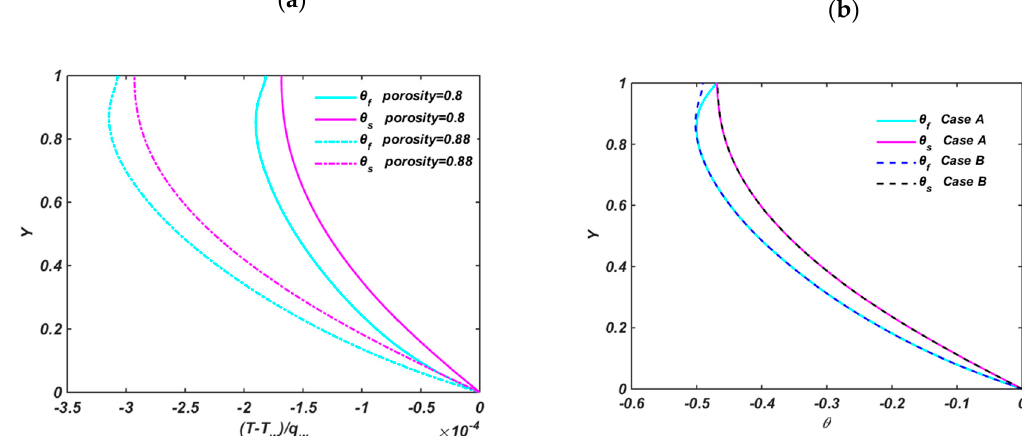
Figure 7. E ff ect of ( a ) porosity and ( b ) adiabatic boundary condition on temperature Figure 7. Effect of ( a ) porosity and ( b ) adiabatic boundary condition on temperature profile.